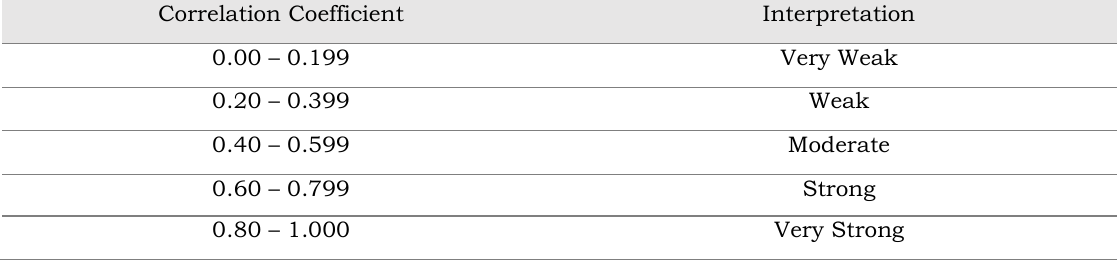
Table 7. Interpretation of the correlation coefficient Correlation